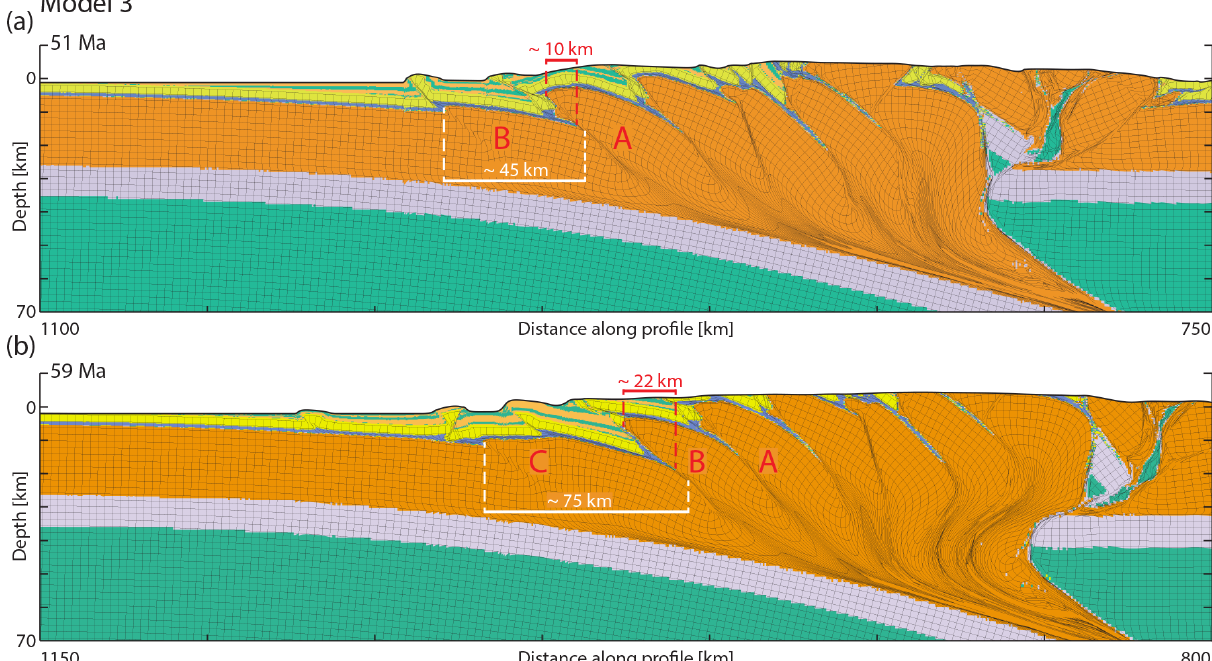
Figure 5. The evolution of Model 3 around the time of increase in sedimentation rate. The material coloring scheme is identical to that used in Fig. 2. (a) Model 3 at 51Myr ( (cid:49)x = 210km), the time of increase in sedimentation rate. White marks show the length of the active external basement thrust sheet (thrusting along Thrust B). The length calculation method is the same as in Fig. 4. Red marks show the amount of displacement along the last abandoned thrust (Thrust A). (b) Model 3 at 59Myr ( (cid:49)x = 290km) at the time of the initiation of the first basement thrust sheet after the increase in sedimentation rate. White marks show the length of the active external basement thrust sheet (thrusting along Thrust C). Red marks show the amount of displacement along the just-abandoned thrust (Thrust B corresponding to Thrust B in a ). Further towards the orogenic hinterlands the steepening Thrust A is shown (corresponding to Thrust A in a